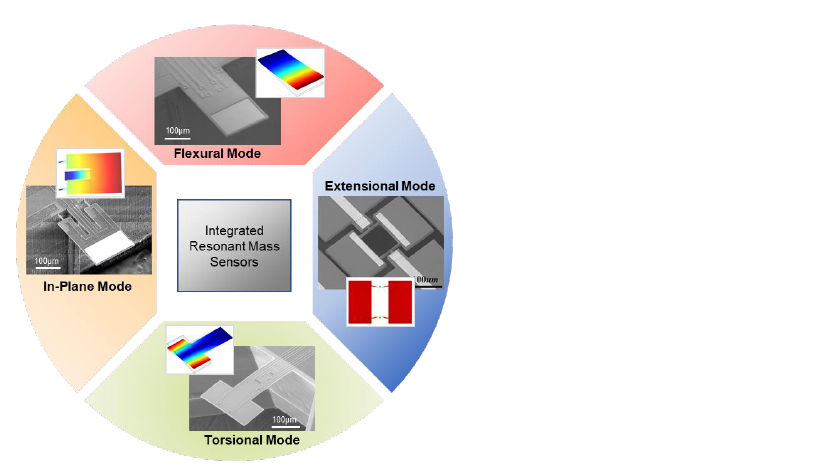
Table 1. Performance of typical integrated resonant gravimetric sensors in air using different vibrational modes. Devices Resonant Frequency Q factor Sensing